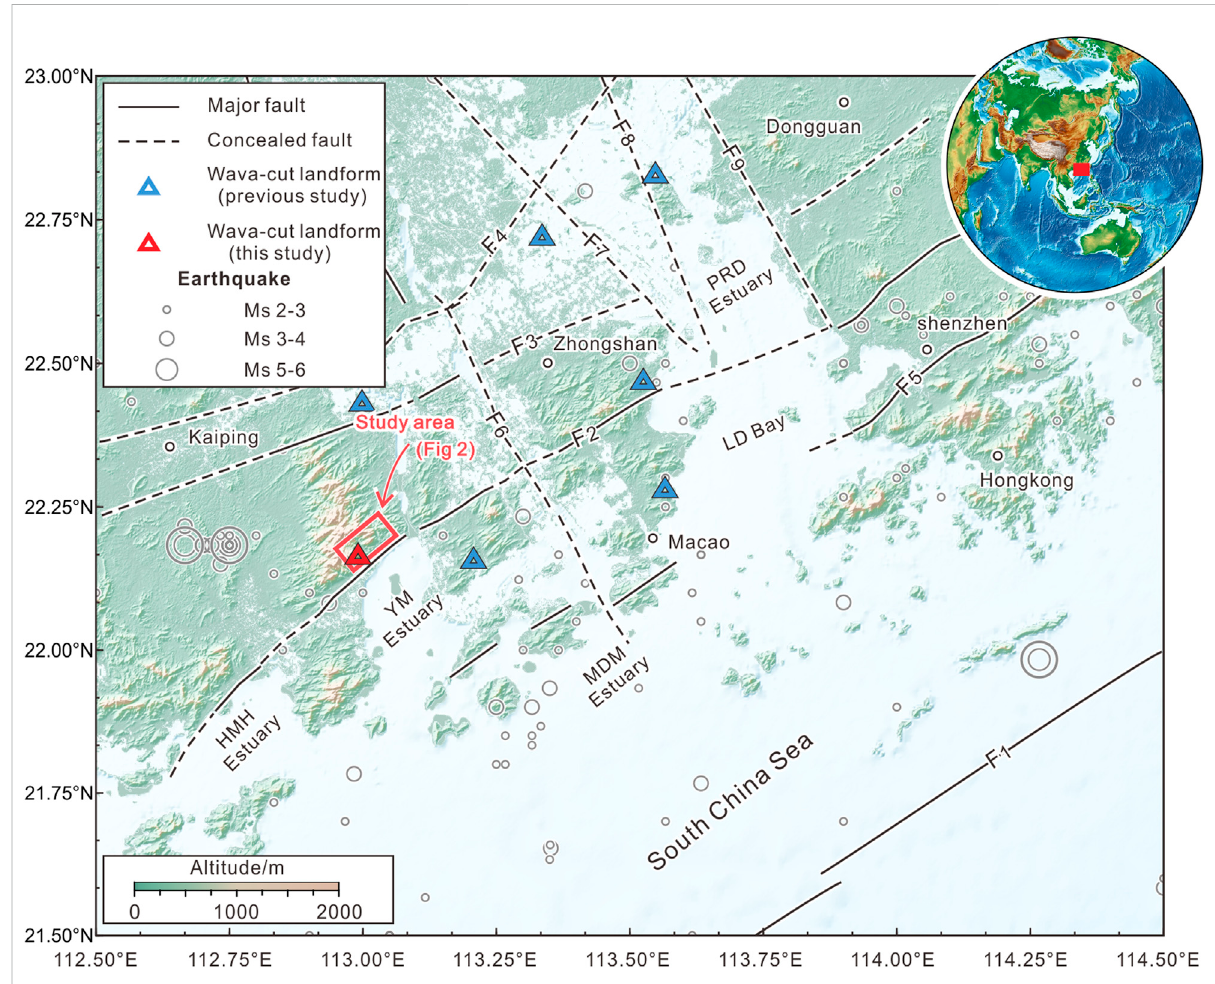
FIGURE 1 TectonicsettingofthenorthernmarginoftheSouthChinaSea,southernChina.Theearthquakelocationsareconstrainedtoadepthof < 30 km between 1976 and 2022 from data from the China Earthquake Network Center and Guangdong Provincial Seismological Bureau. The faults are adaptedfromHuangetal.(1982),Yuetal.(2016),andHuangetal.(2021).Thelocationsofthewave-cutplatformsinpreviousstudiesarefromHuang et al. (1982), Jiang and Hu (1994), Wang et al. (2011), and Zhao (2017). F1: Littoral Fault Zone; F2: South Wuguishan Fault; F3: North Wuguishan Fault; F4: Xinhui – Shiqiao Fault; F5: Wuhua – Shenzhen Fault; F6: Xijiang Fault; F7: Baini – Shawan Fault; F8: Hualong – Huangge Fault; F9: Nangang – Taiping Fault. The topography is from the Shuttle Radar Topography Mission (SRTM) digital elevation model at 90-m